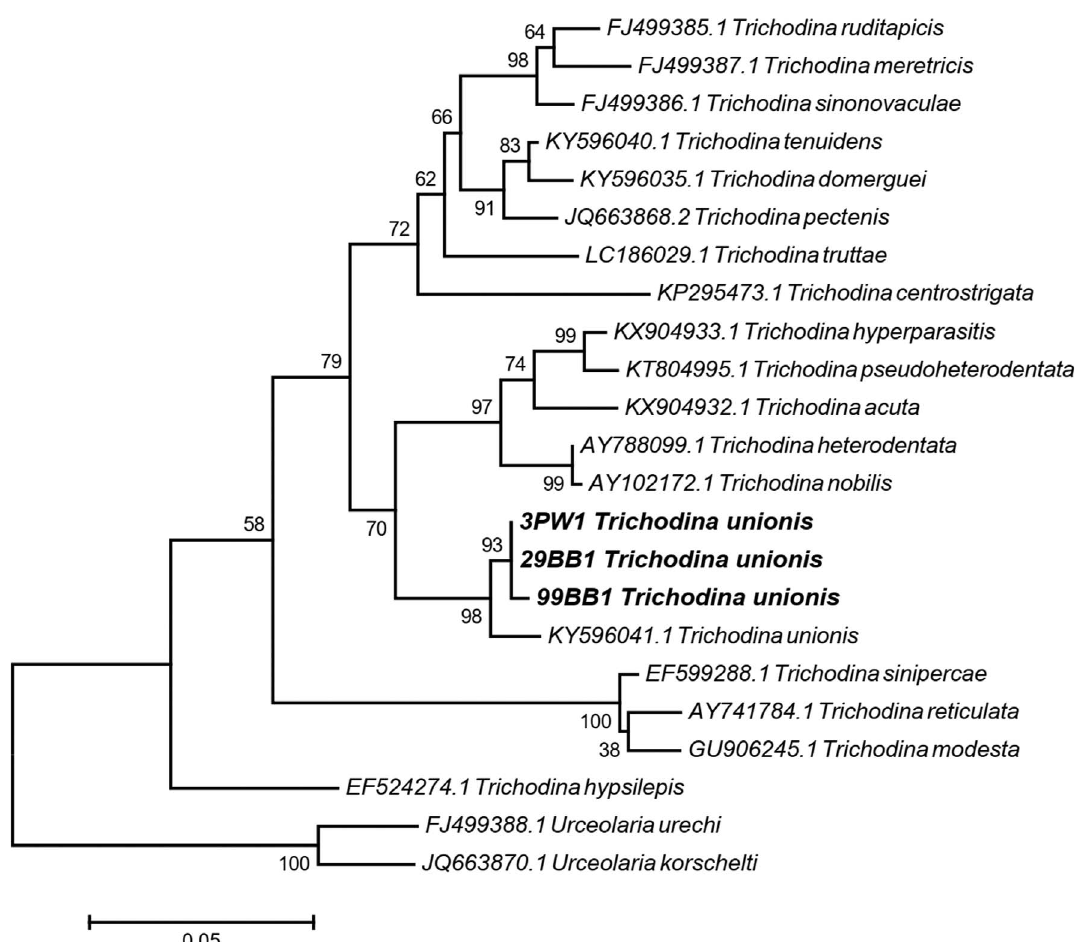
Figure 5. The rooted phylogenetic tree of the trichodinids from the partial 18S rRNA region using the maximum likelihood method. Numbers at each node represent maximum likelihood bootstrap values from 10,000 replicates. The bold taxa refer to trichodinids in this study. The scale bar was drawn as branch lengths measured in the number of substitutions per site of